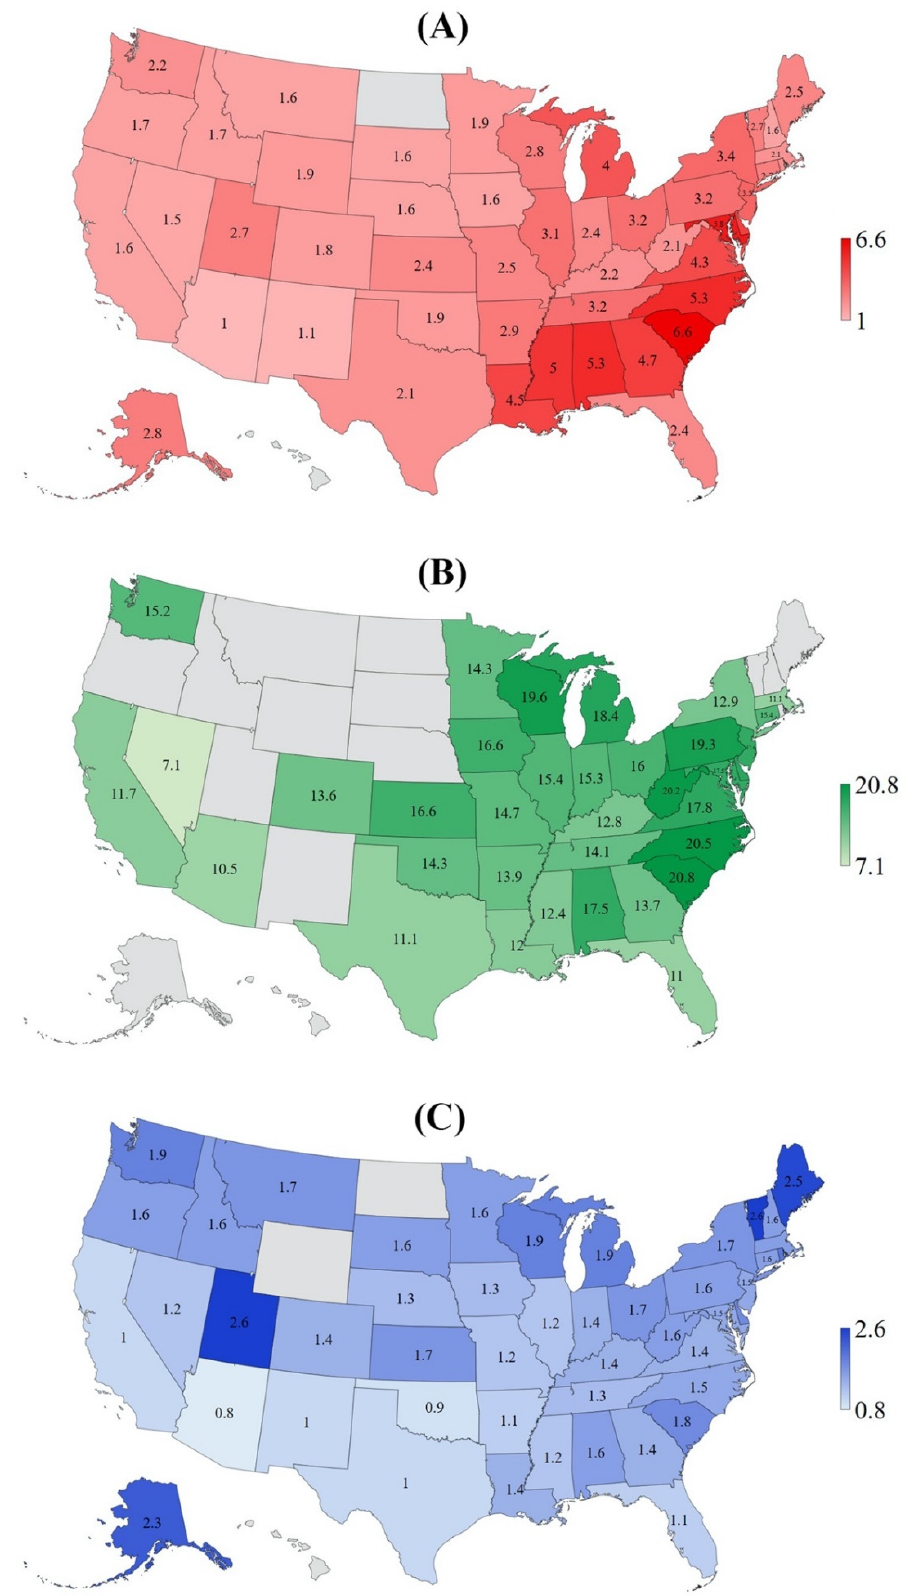
Figure 1. Map of Sarcoidosis-Related AAMR (age-adjusted mortality rate) per 1,000,000 for ( A ) All Population, ( B ) African Americans, and ( C ) European Americans for 50 States of the US, 1999 to 2018.